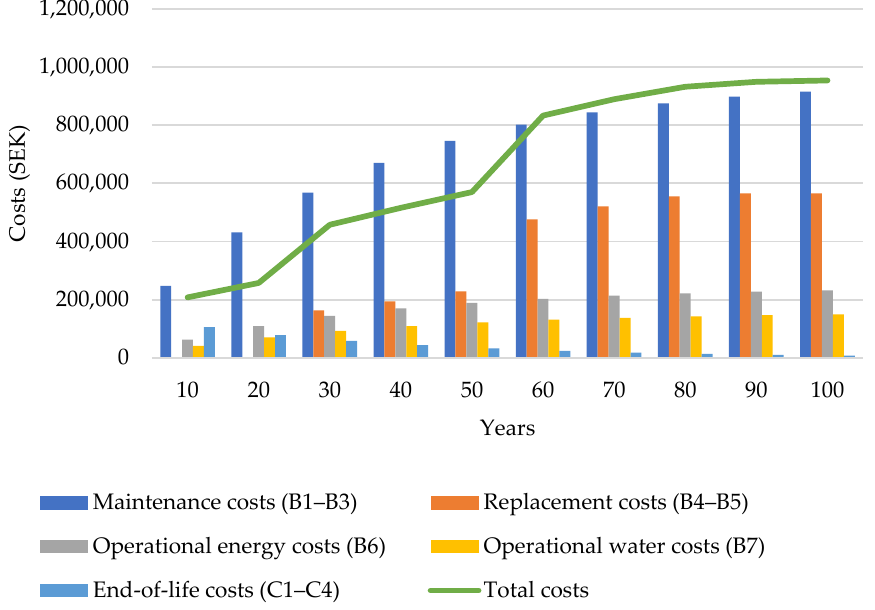
Figure 4. Running costs through different lifespans of the house.